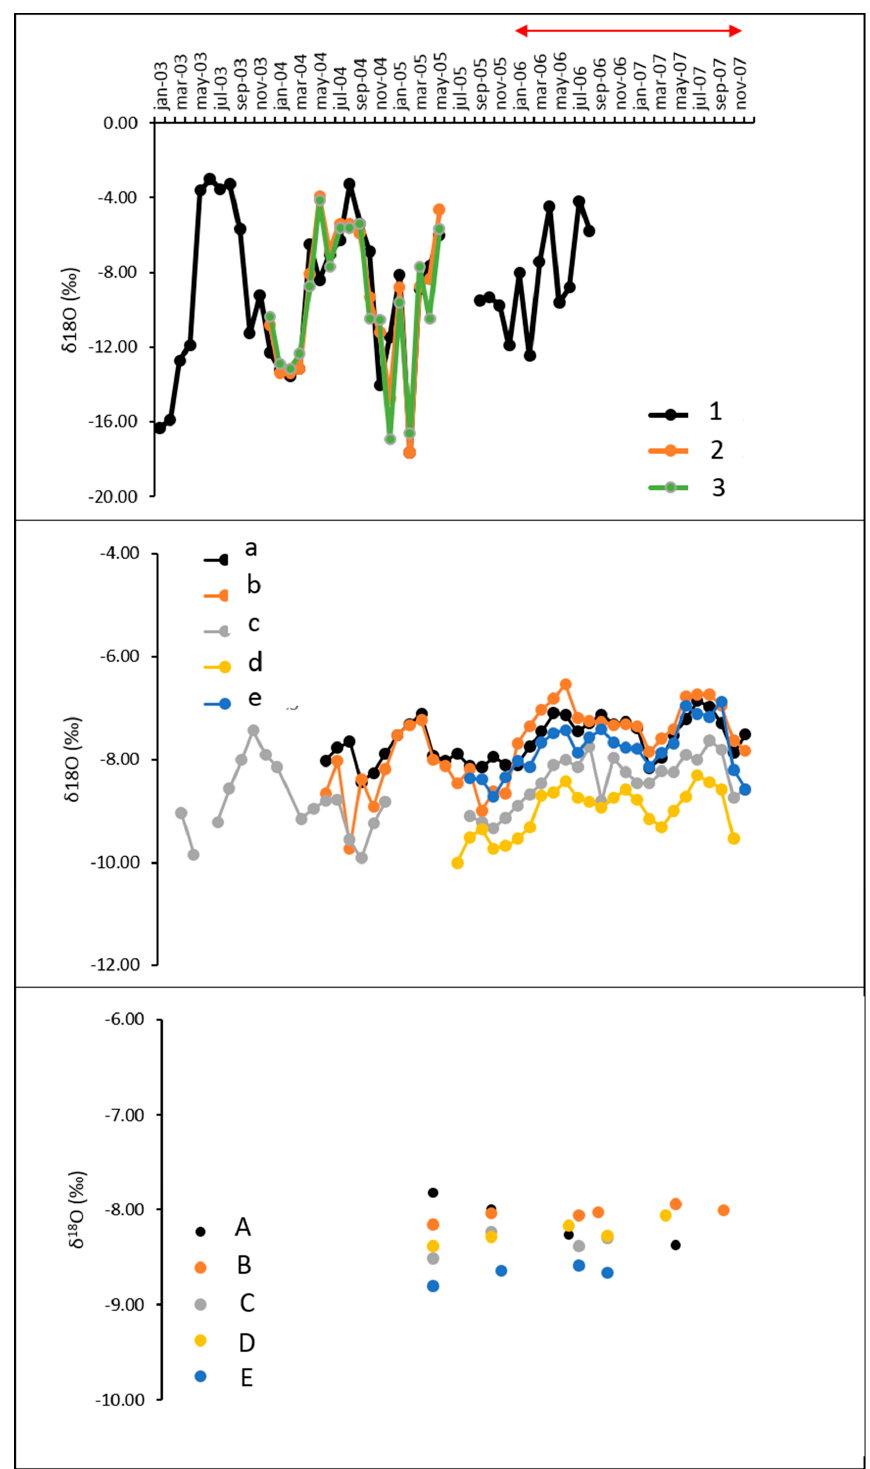
Figure 4. Pattern of δ 18 O in precipitations (above), surface water (central) and groundwater (below) from the apical parts of alluvial fans. Letters from a to e and numbers from 1 to 3 recall surface water and precipitation, respectively. Capital letters from A to E refer to groundwater from the apex part of each alluvial fan (in form of aggregated isotopic values from all the wells). The red bar indicates the time period (from January 2005 to December 2007) over which the statistical analyses on surface water and groundwater were carried